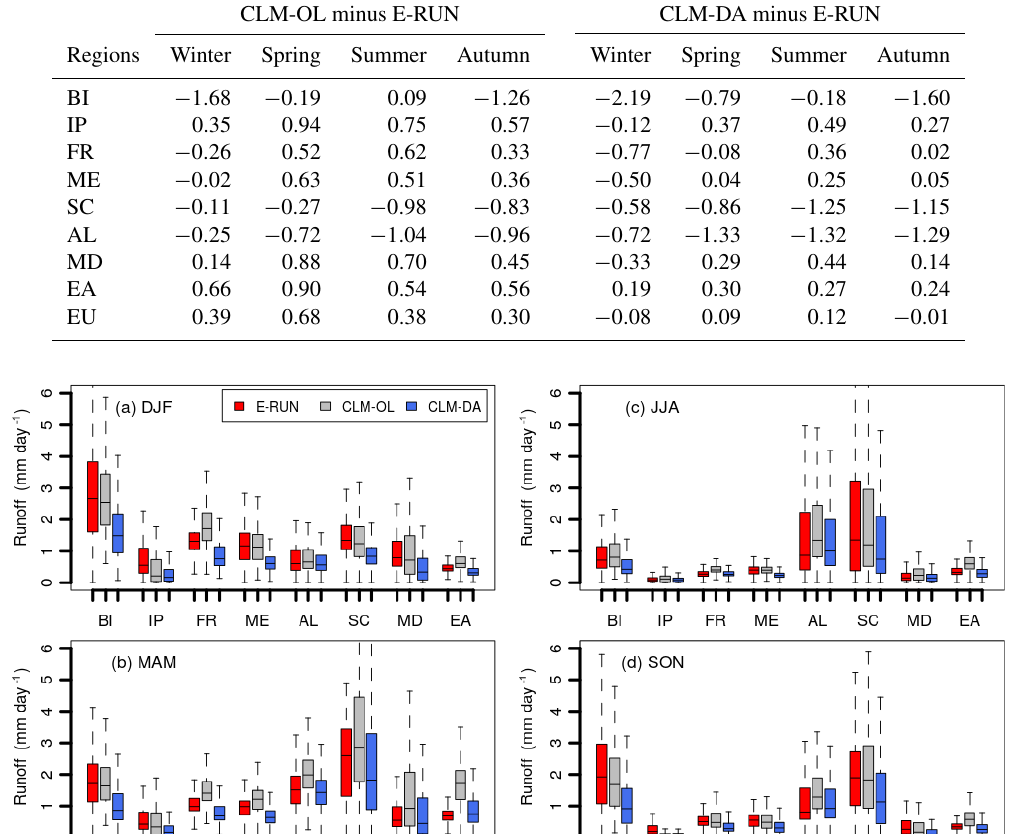
Table 3. Monthly mean bias (CLM minus E-RUN) in mean seasonal runoff (mmday − 1 ) for CLM-OL and CLM-DA for all PRUDENCE regions and all seasons, i.e., winter (DJF), spring (MAM), summer (JJA) and autumn (SON).